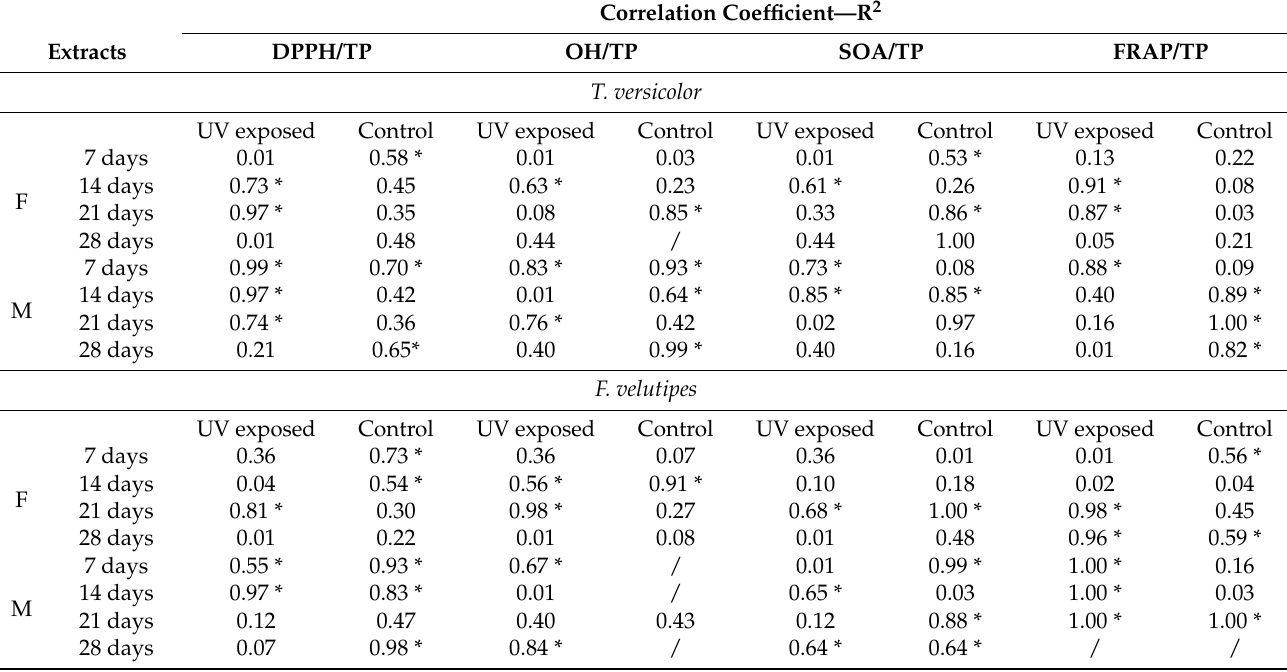
Table 4. Correlation between TP and determined AO properties of analyzed extracts. Correlation Coefficient—R 2